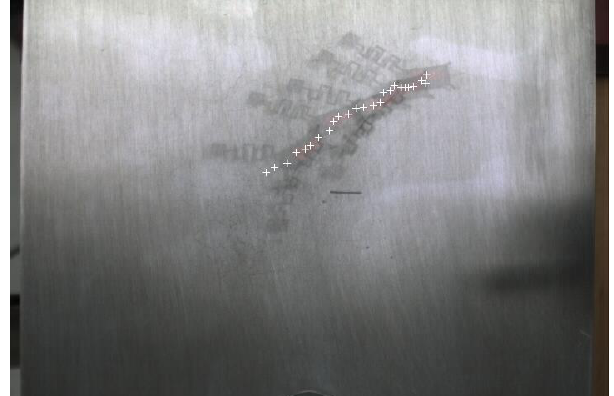
Figure 8. Sample trajectory of robot at 686